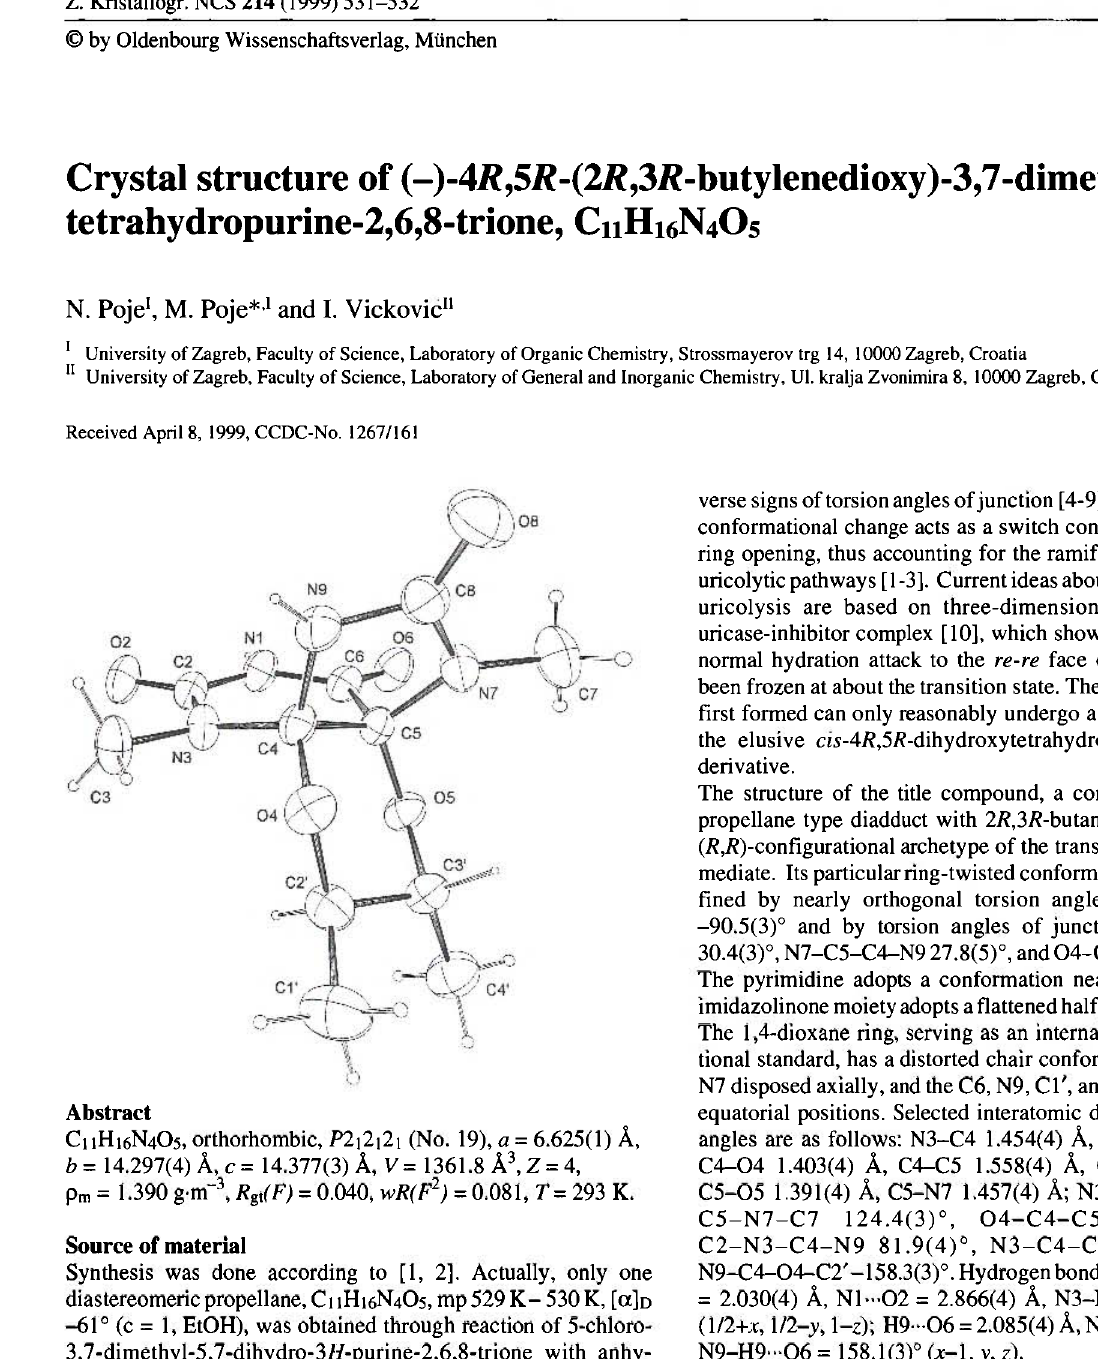
Table 1. Data collection and handling.